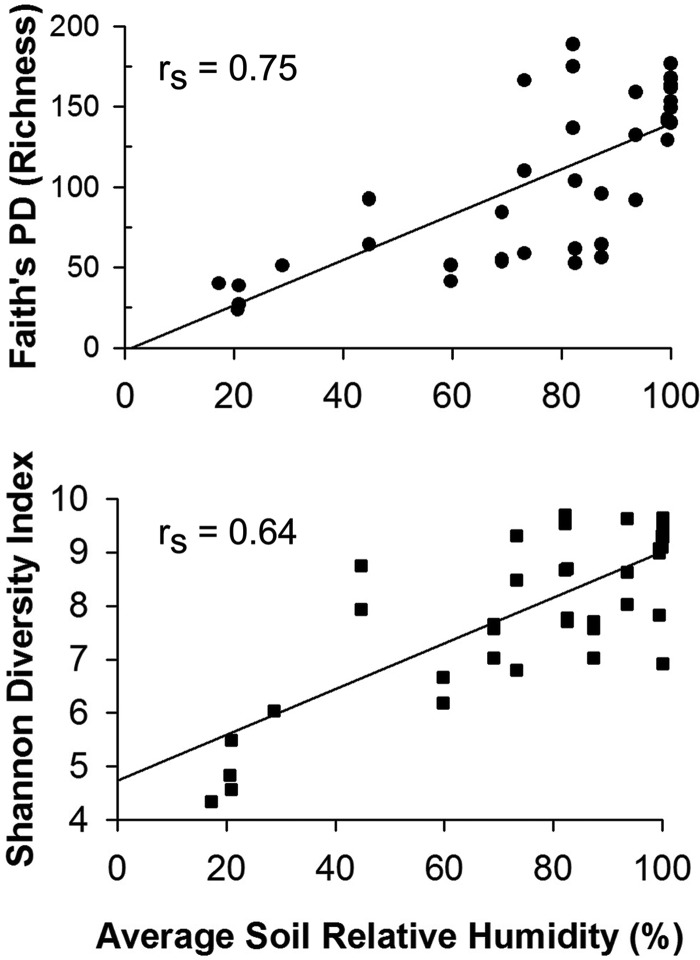
Correlation between average soil relative humidity and microbial richness (PD) (top panel) and diversity (Shannon index) (bottom panel); rs = Spearman’s rank correlation, P < 0.0001.